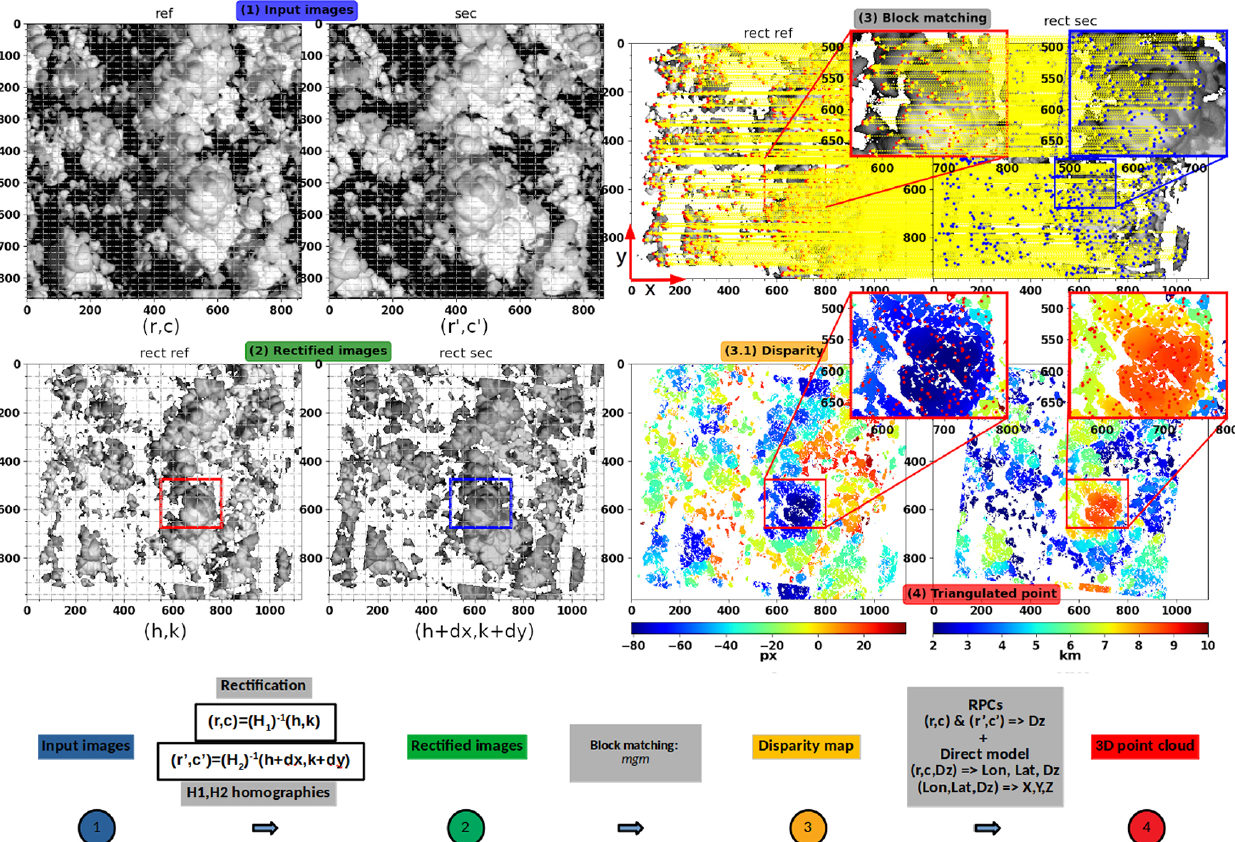
Figure 8. Step-by-step 3D reconstruction vias2p algorithm. Top left: reference and secondary images (ref, sec). Notice that ref and sec have been rotated 90 ◦ clockwise for consistency, with the orientation of the along track direction x . Bottom left: (2) rectified images (rect ref, rect sec). Top right: (3) tie points from block matching; (3.1) disparity map; (4) 3D reconstructed point cloud ( z – altitude from ground). These calculations were obtained using acquisition